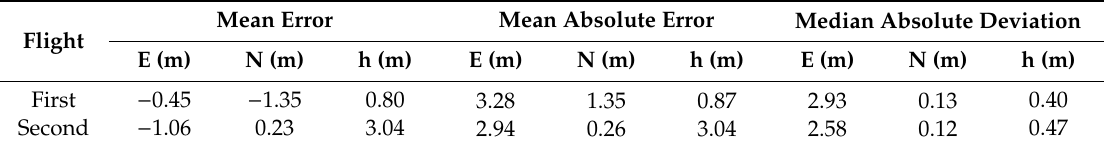
Table 3. Basic statistics of di ff erences between the single-frequency and dual-frequency exposure (camera) position estimates for the first and second flights (E—easting, N—northing, h—altitude). Mean Flight